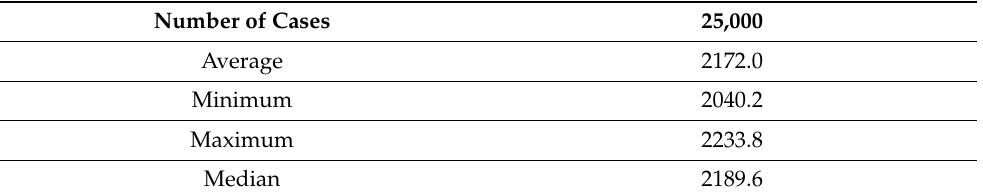
Table 2. Descriptive parameters of the set of values of H year (kWh/m 2